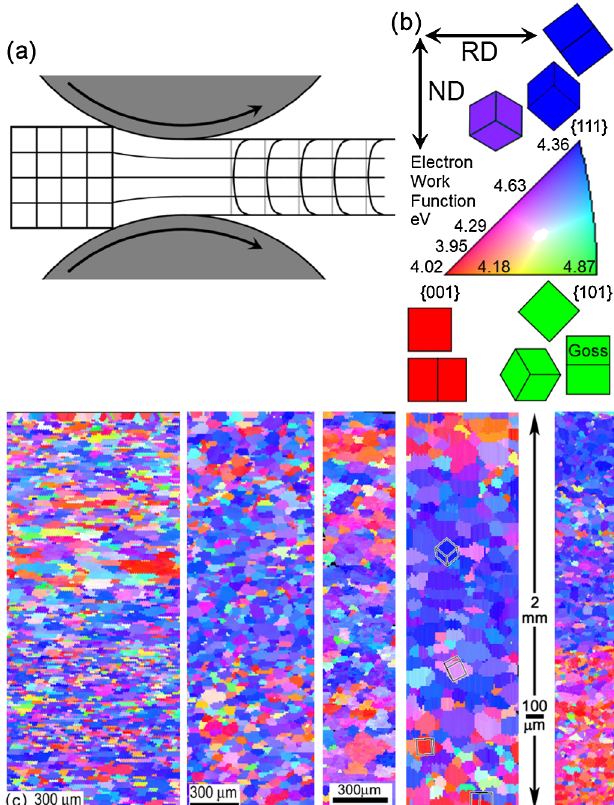
FIG. 10. (Color) Schematic diagram (a) illustrates how the strain path differs between the surface and center of rolled sheet, resulting in different distributions of grain orientations based upon the color convention illustrated (b, where the electron work function values are also indicated for different surface normal directions [21]). Five examples of full thickness orientation maps (c) from high purity Nb commercially rolled to (cid:2) 2 mm thick [20] show a trend of preferred f 100 g orientations near the surface and f 111 g orientations in the interior. The microstructure and texture gradients vary widely from sample to sample. These orientation maps are with respect to the vertical sheet normal direction (ND) in the interior, and grains on the surface to have f 100 g parallel to the ND, for example, the f 100 gh 011 i 2 rotated cube orientation. More commonly, a range of orientations with a common crystal direction normal to the sheet are found, such as f 100 g k ND [i.e. red orientations in Figs. 10(b) and 10(c) [20] ]. Similarly, f 111 g k ND pre- ferred orientations are also common (named the (cid:2) fiber;